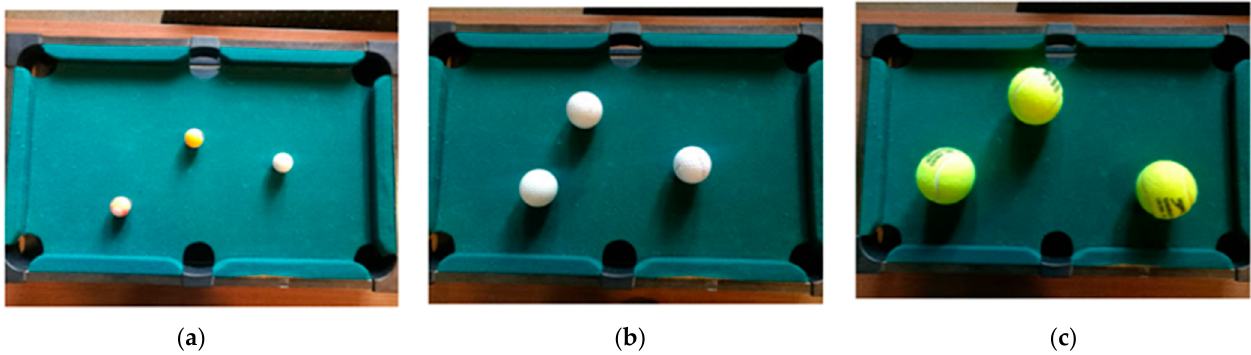
Figure 8. PPE and social distance protocol represented by the size of the balls. With face masks of high quality as shown in images ( a ), with ordinary masks in ( b ), with no mask in ( c ). In ( a ) people must be very close in order to have a higher probability of transmission whereas in ( c ) it is enough to be a couple of meters from each other to transmit the virus.